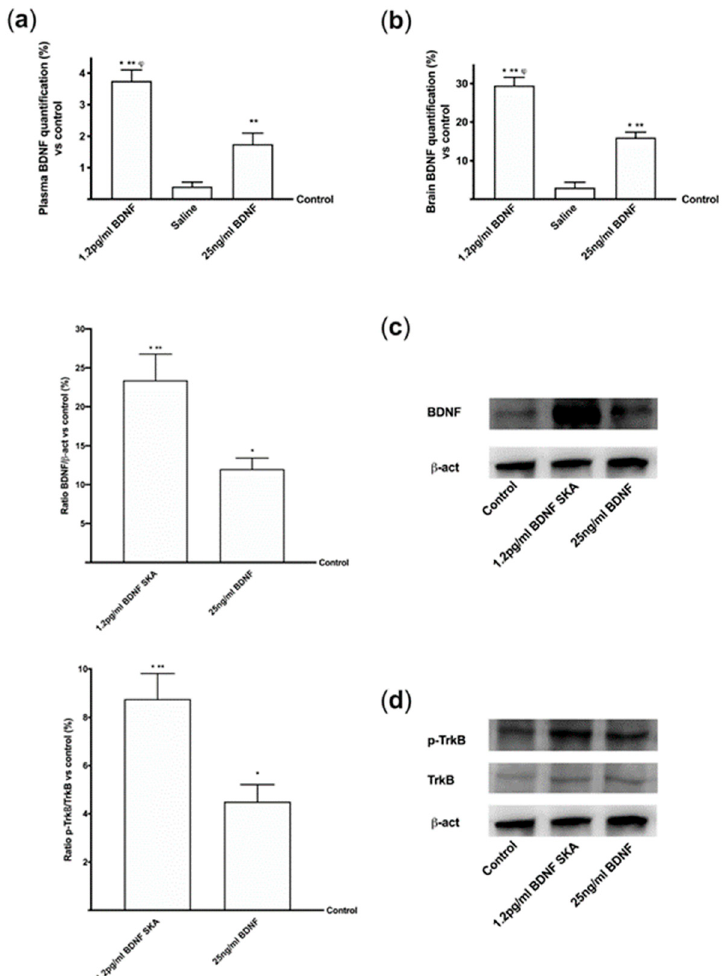
Figure 11. BDNF quantification and intracellular pathways in brain measured in the 6-dayprotocol. ( a ) Serum and ( b ) brain tissue BDNF quantification in mice. Data are expressed as means ± SD (%) of n = 7 independent experiments normalized to control value (0 line). * p < 0.05 vs. control; ** p < 0.05 vs. saline solution; ϕ p < 0.05 vs. 25ng / mL BDNF. ( c ) BDNF and ( d ) TrkB receptor expressions in mice brain reported as densitometric analysis (on the left) and examples of Western blot (on the right). Data are expressed as means ± SD (%) of n = 7 independent experiments normalized on specific total protein if possible and verified by β -actin detection. * p < 0.05 vs. control; ** p < 0.05 vs. 25 ng / mL BDNF.